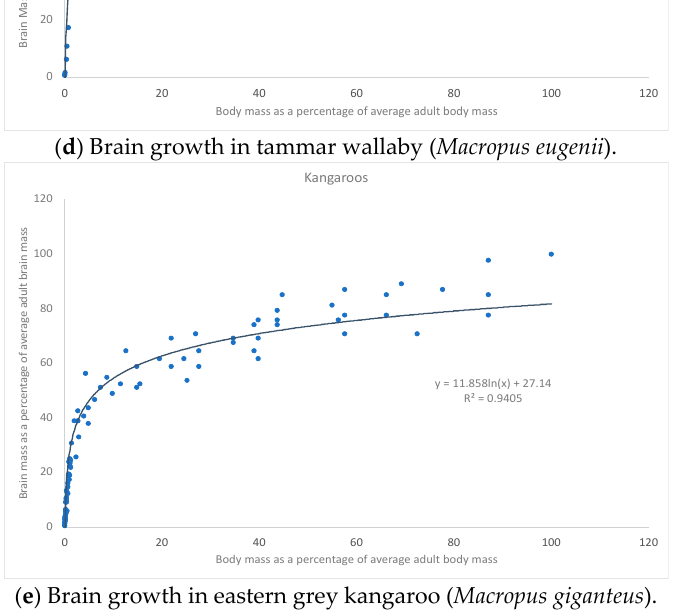
( e ) Brain growth in eastern grey kangaroo ( Macropus giganteus ).